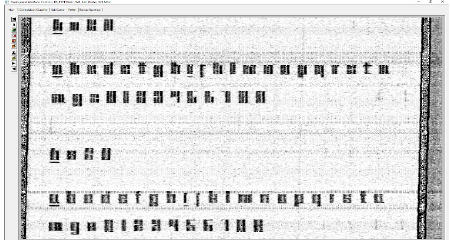
Figure 17. Image recovered with Font 28 with blank spaces: secure asymmetrical and secure symmetrical.